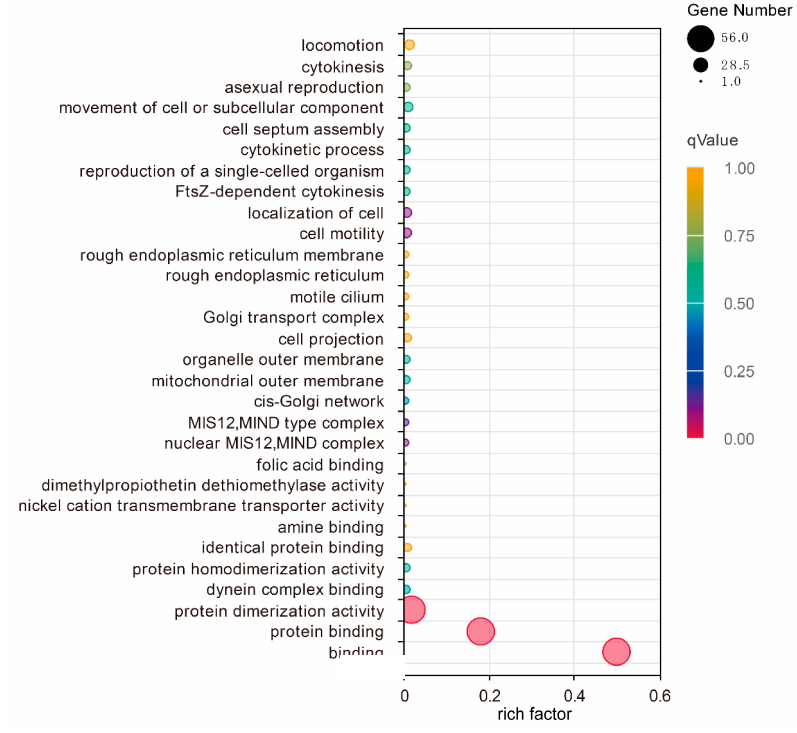
Figure 3. GO annotation of 59 bHLH transcription factors. The dot size represents gene number, and different colours represent the values of the qValue. Table 2. Ka, Ks, and Ka:Ks values between homologous bHLH gene